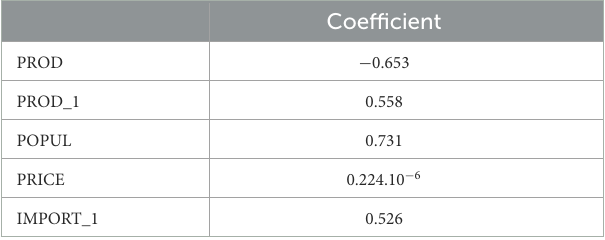
TABLE 9 Elasticity coefficients in % estimated from the ADL